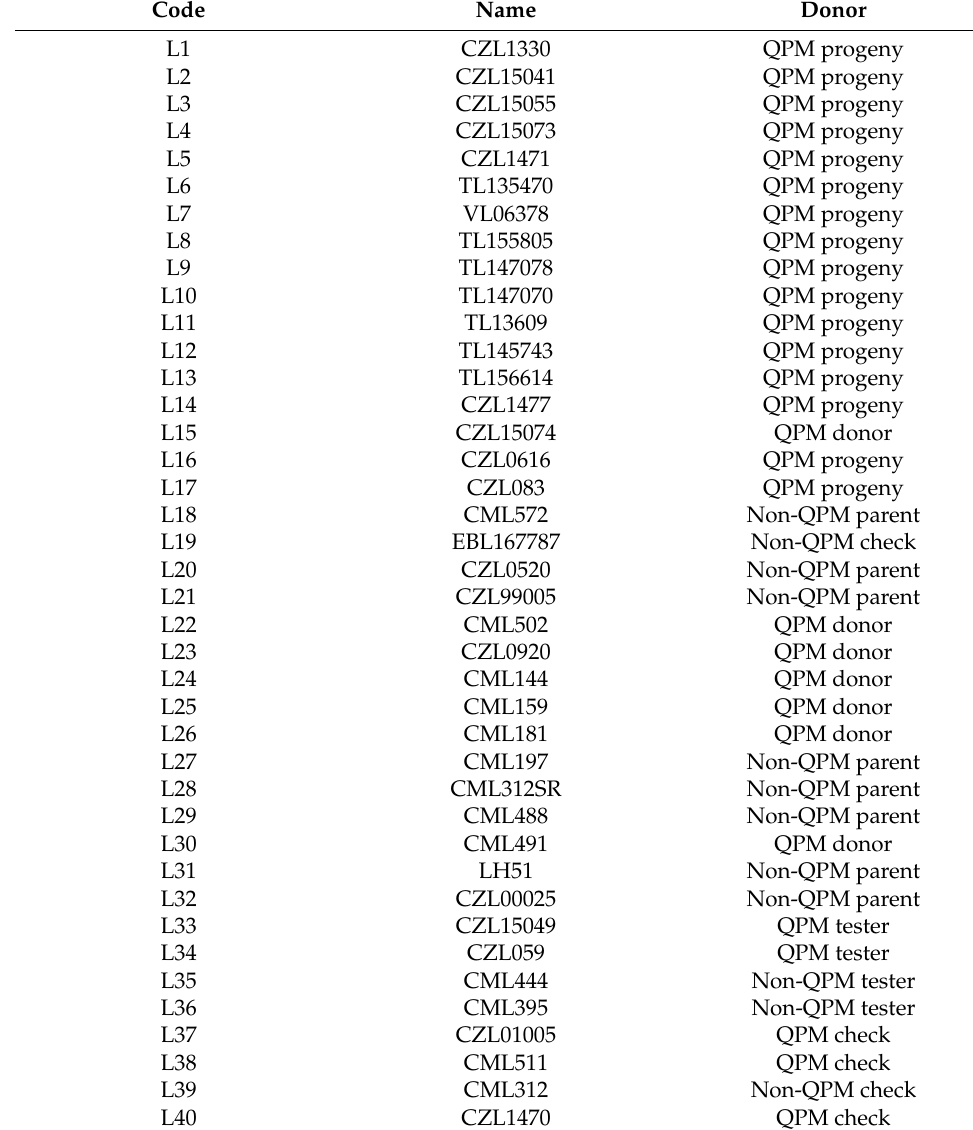
Table 1. Description of the QPM and non-QPM inbred lines and checks used in the study.